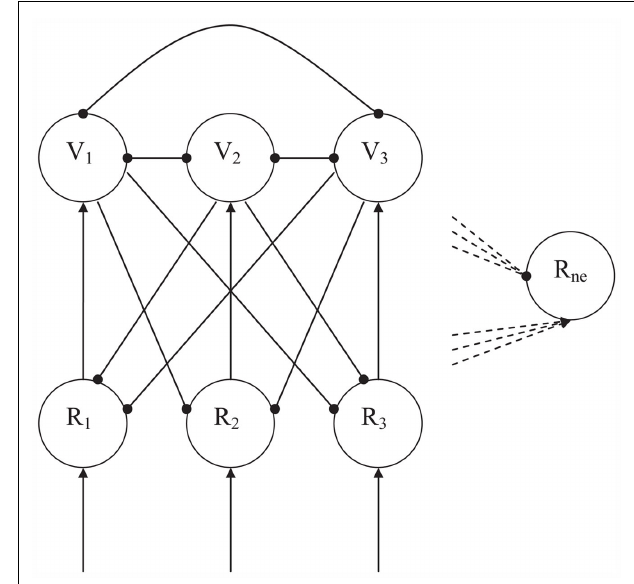
FIGURE 3 |The CALM module with monitoring ability of level of competition. Arrows denote excitatory connections, globules inhibitory connections. Input is represented on the representation nodes (R n ).The inhibitoryVeto nodes (V n ) enable competition between potential representations.When there is much competition, the sum of activations from the R-nodes and inhibitions from theV-nodes to the Negative node (R ne ) will be positive.With little competition this sum will be negative and the R ne node will not be